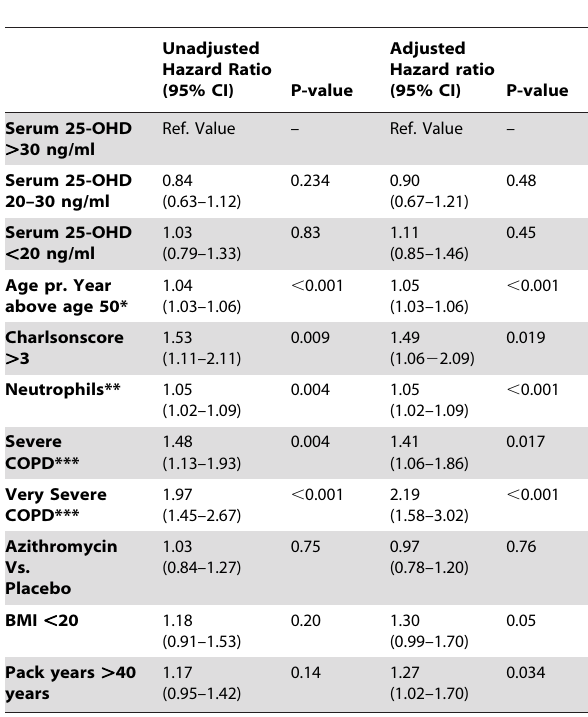
Table 2. Uni- and multivariate Proportional Hazard Cox Regression of prognostic markers for